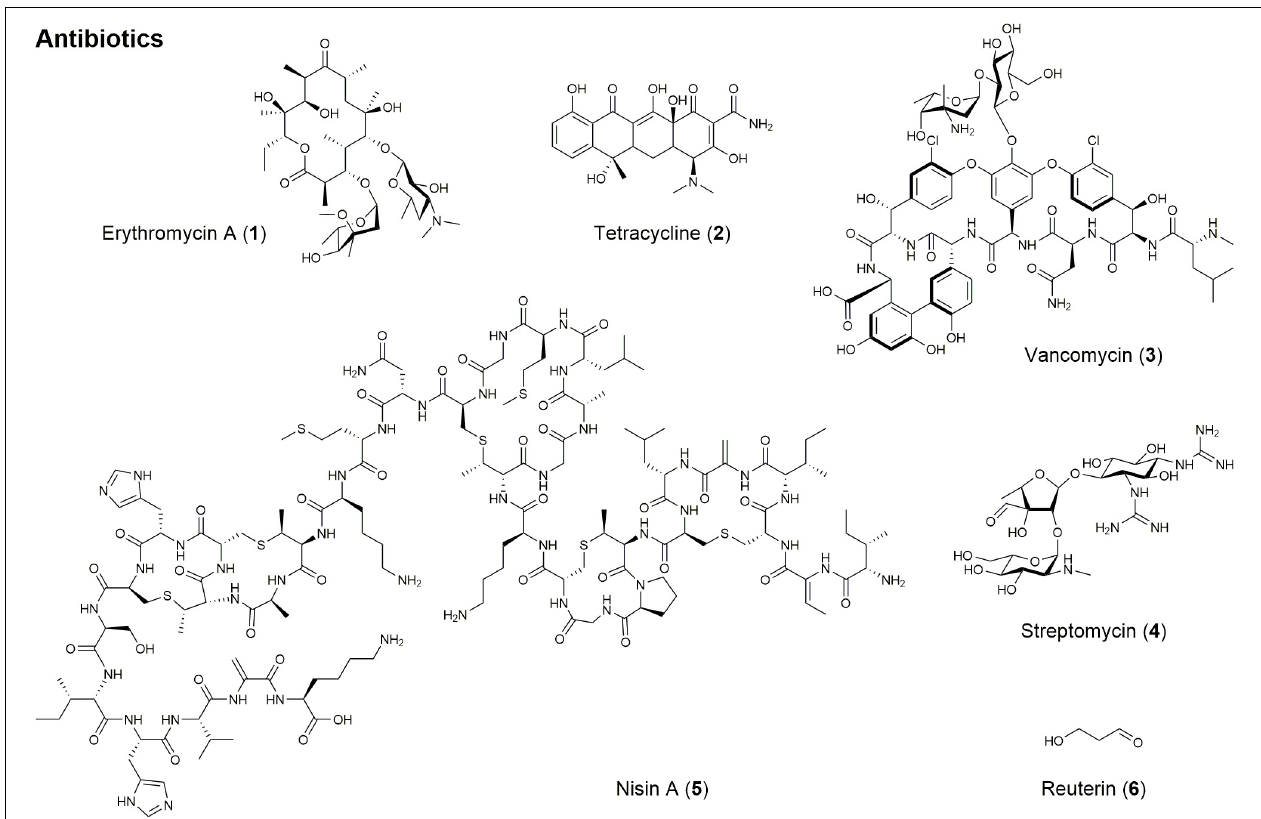
FIGURE 1 | Structures of natural products with antibiotic